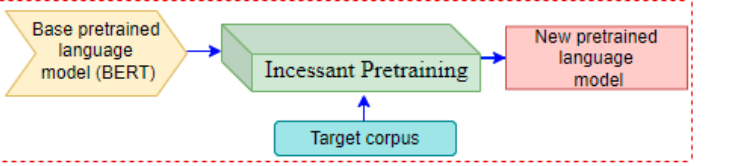
Figure 5. Incessant pretraining process (in this case, the pre-training task is progressively con- structed, and the models are pre-trained and fi ne-tuned to respond to di ff erent language under- standing tasks).